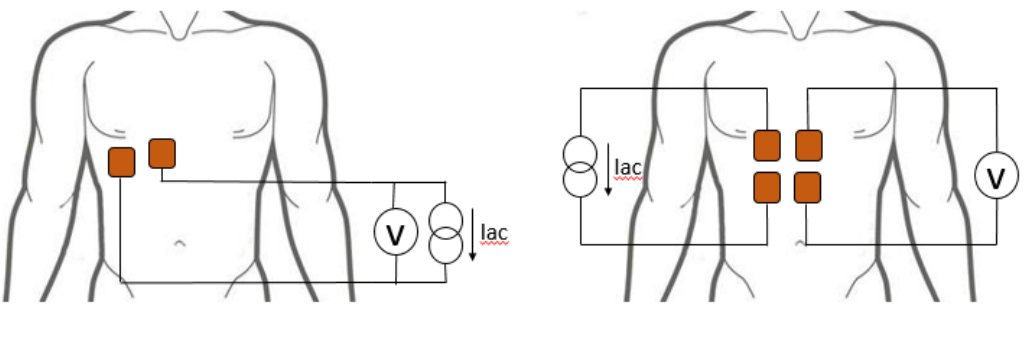
Figure 1. Configuration of electrodes for the alternate current injection (Iac) and the acquisition of impedance pneumography (IP) in a bipolar ( left ) and tetrapolar ( right )